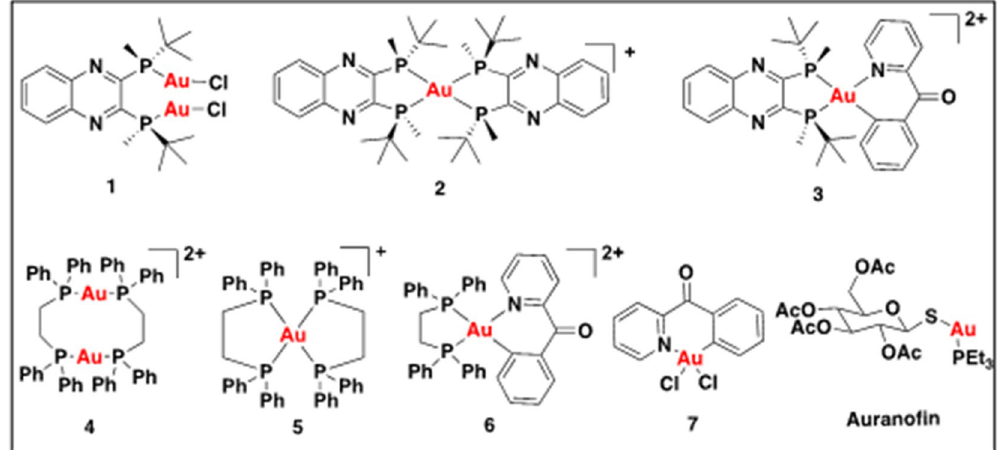
Figure 1. Chemical structures of gold complexes under